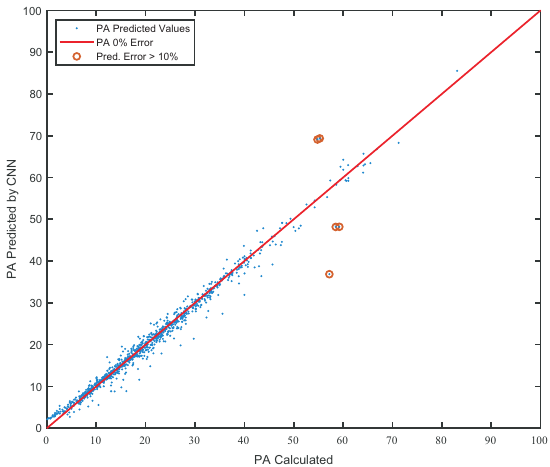
Figure 4. PA Calculated vs. PA Predicted by CNN. Predicted PA values with Error > 10% marked.